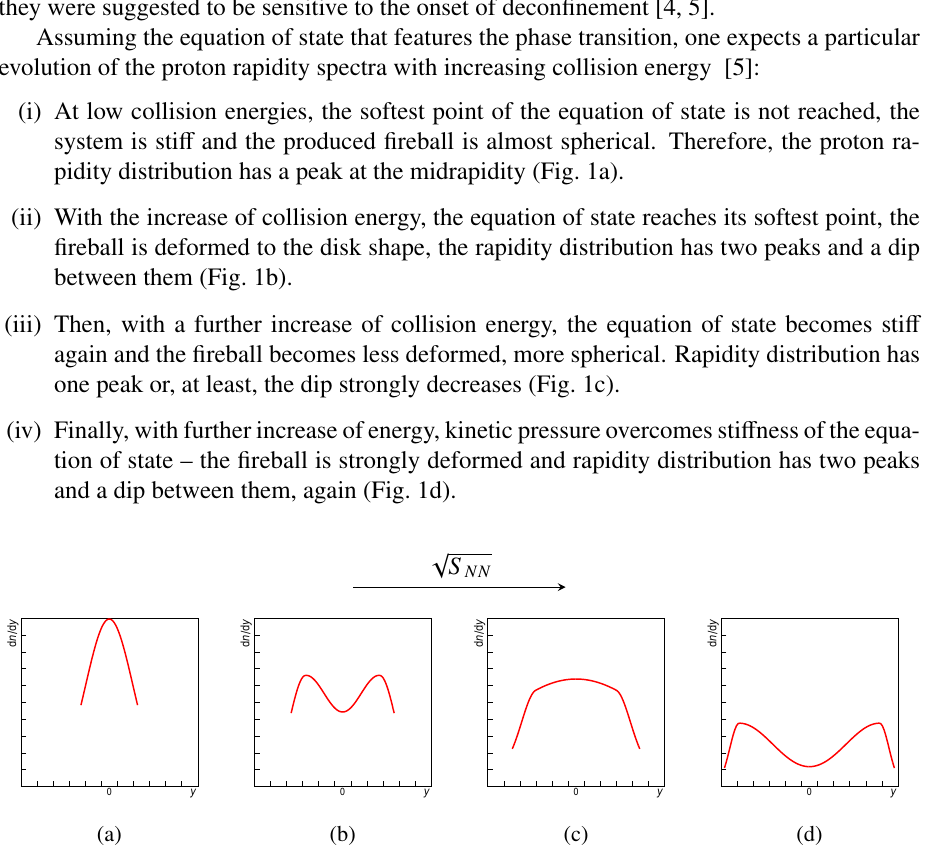
Figure 1: Sketch describing “peak-dip-peak-dip” irregularity, proposed as a signal of decon- finement in Ref.